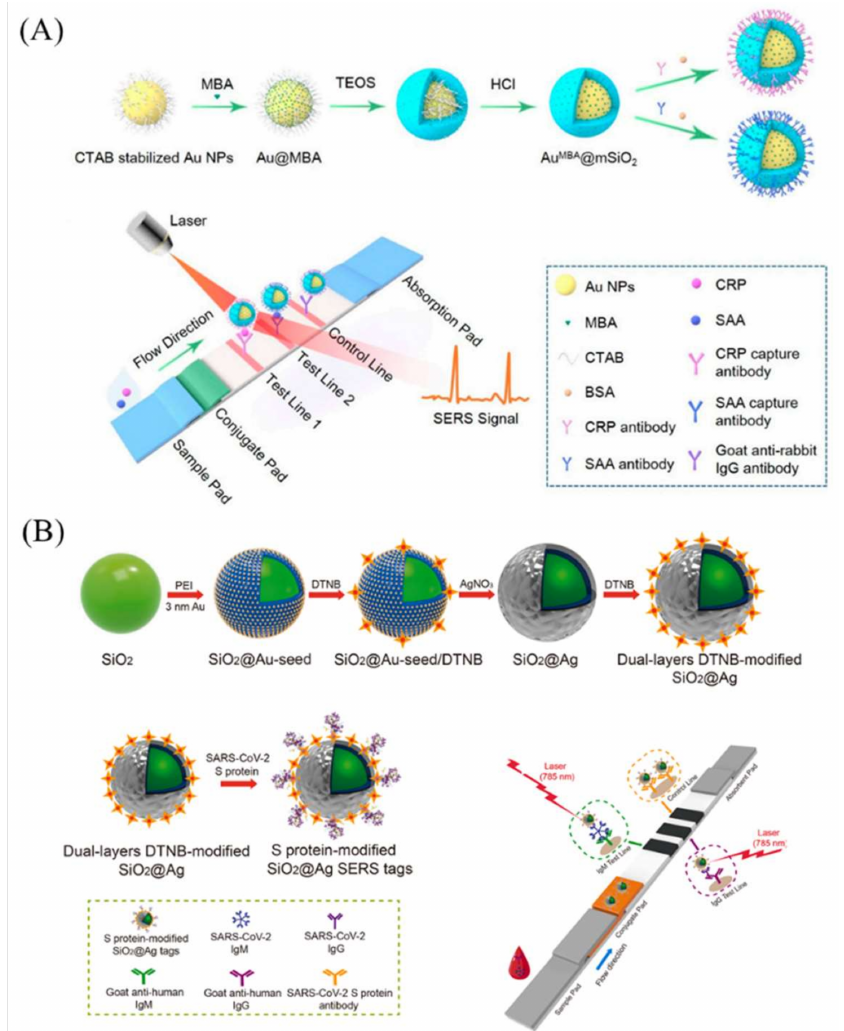
Figure 6. Silica-nanomaterial-assisted SERS-LFA. ( A ) Core–shell Au/MBA@mSiO 2 nanoparticles used as SERS-LFA labels for co-detection of CRP and SAA. ( B ) Silica sphere immobilized dual- layer Raman reporters for anti-SARS-CoV-2 IgM/IgG detection. Reprinted with permission from References